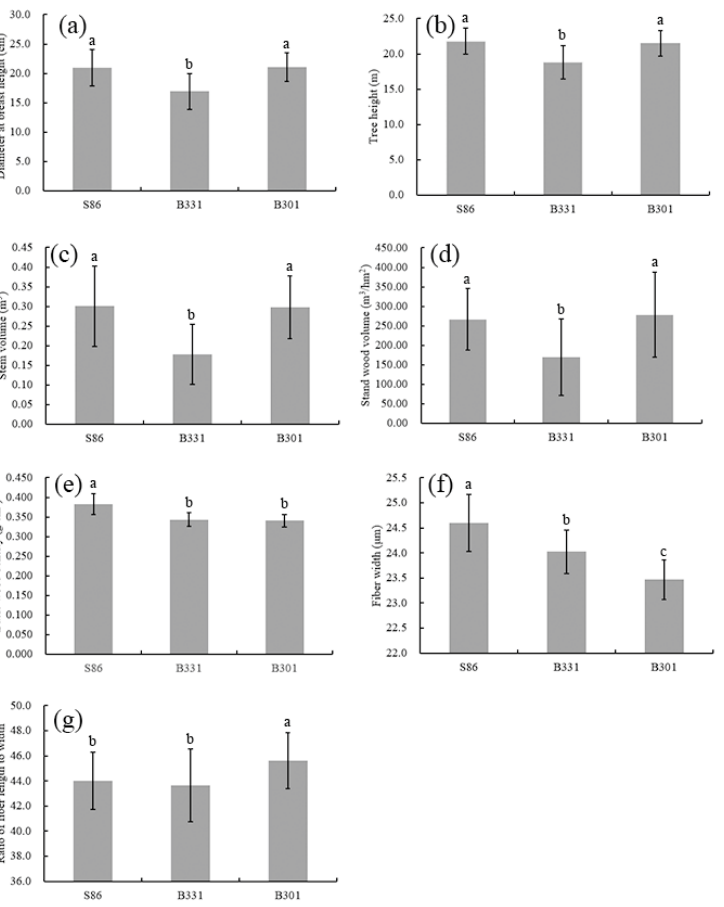
Figure 3. Clonal effects on growth traits and wood properties of triploid Chinese white poplar regardless of planting densities: ( a ) DBH of triploid Chinese white poplar. ( b ) H of triploid Chinese white poplar. ( c ) SV of triploid Chinese white poplar. ( d ) SWV of triploid Chinese white poplar. ( e ) BWD of triploid Chinese white poplar. ( f ) FW of triploid Chinese white poplar. ( g ) FL/FW of triploid Chinese white poplar. Lowercase letters indicate significance at the p < 0.05 level.